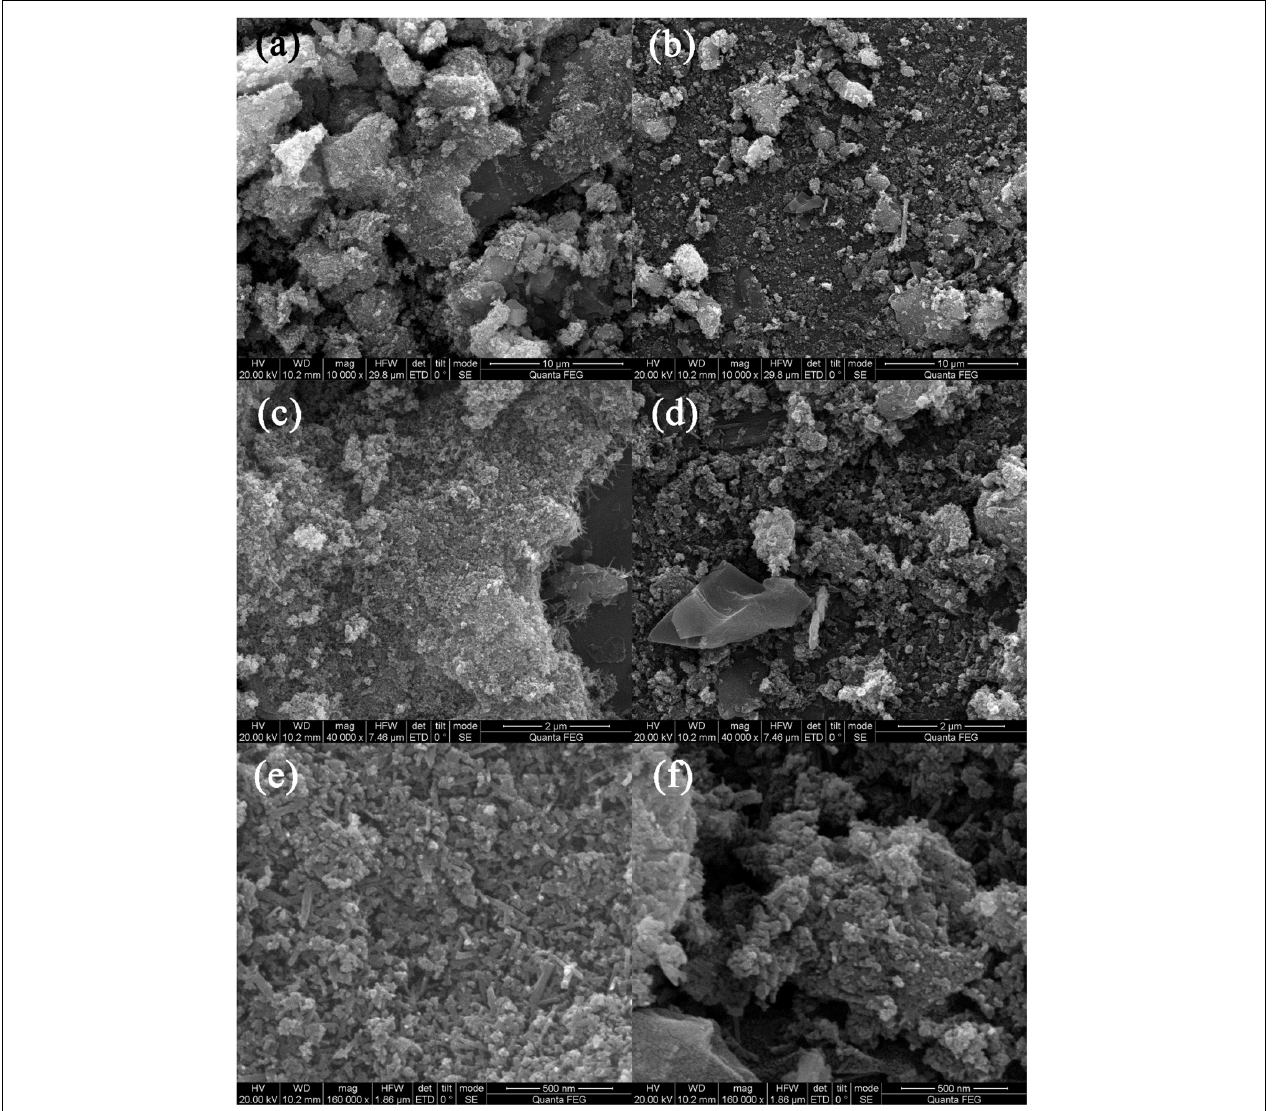
FIGURE 2 | SEM images of BC/MnO 2 under different magnification: (a,b) 10000 × , (c,d) 40000 × , and (e,f) 160000 × .